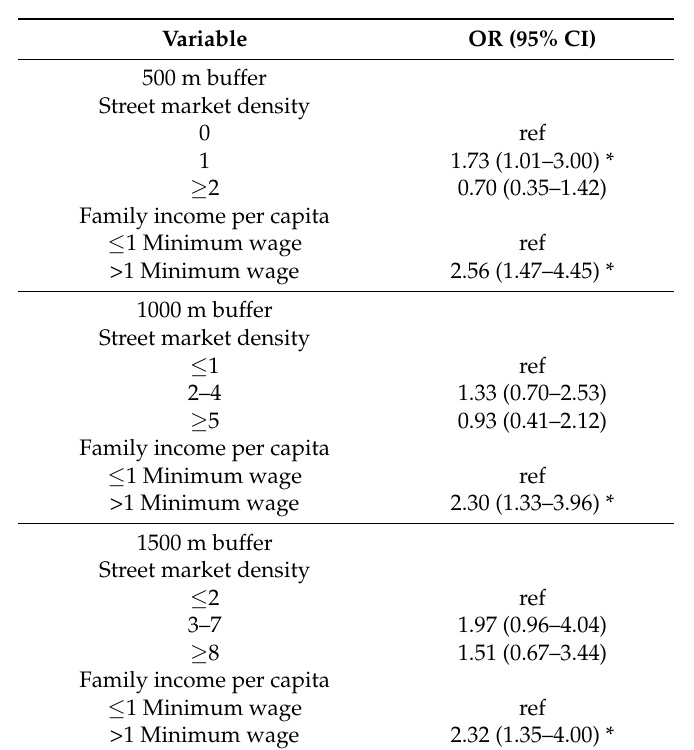
Table 2. Odds ratios for associations between fruits and vegetables consumption, income, and street market density in different buffers sizes. ISA-Capital, city of S ã o Paulo,